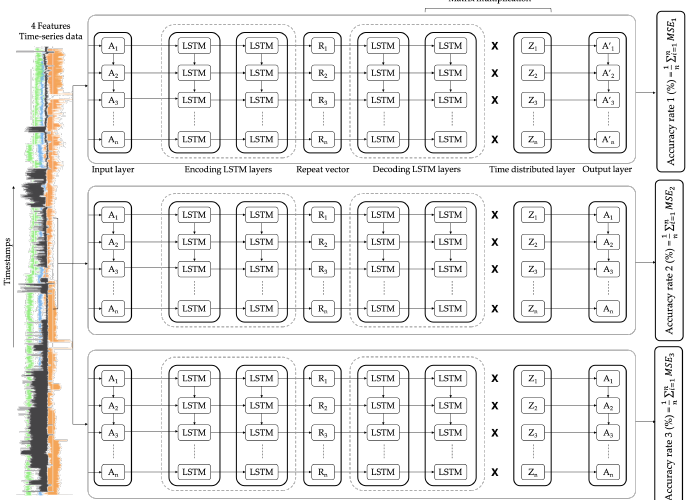
Figure 4. LSTM-autoencoder architecture